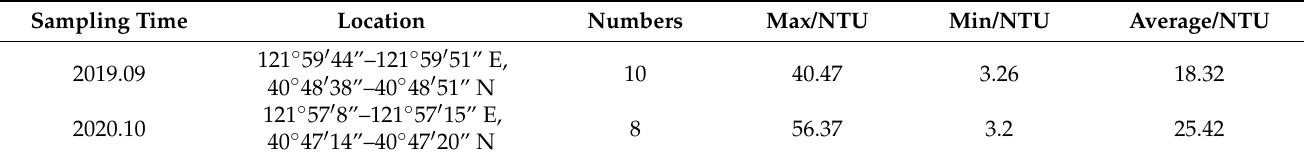
Table 1. Turbidity statistics of sampling points.